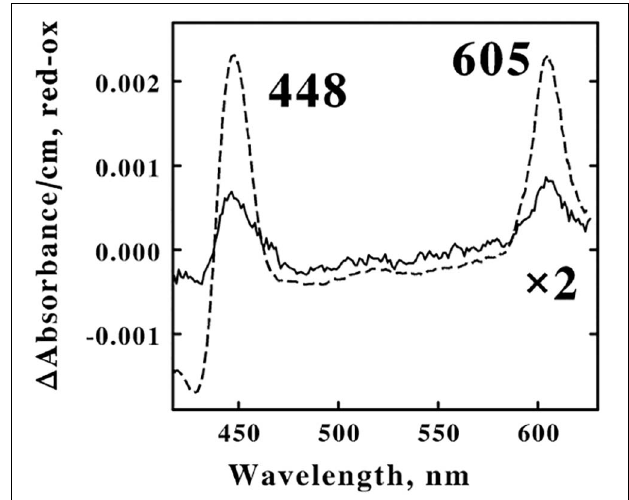
FIGURE 6 | Identification of the principal electron transfer component that was reduced when intact F. acidiphilum was in the cathodic phase of repetitive cyclic voltammetry. Both curves are difference spectra representing the absolute spectrum of the reduced bacterium minus that of the air-oxidized bacterium. The dashed spectrum was obtained 0.5 s after 1.6 × 10 9 cells/ml were mixed with 4.0 mM ferrous sulfate, pH 1.5 at 30 o C. The solid spectrum was obtained from the cathodic portions (from 0.8 to 0.2 V vs. the SHE, inclusive) of multiple cyclic voltammetry measurements on 1.6 × 10 9 cells/ml conducted in sulfuric acid, pH 1.5 at 30 o C; the scan rate was 100 mV/s. 1 The abbreviations used are: SHE, standard hydrogen electrode; CV, cyclic voltammetry; CC, chronocoulometry; and tBLASTn, Basic Local Alignment Search Tool to search translated nucleotide databases using a protein